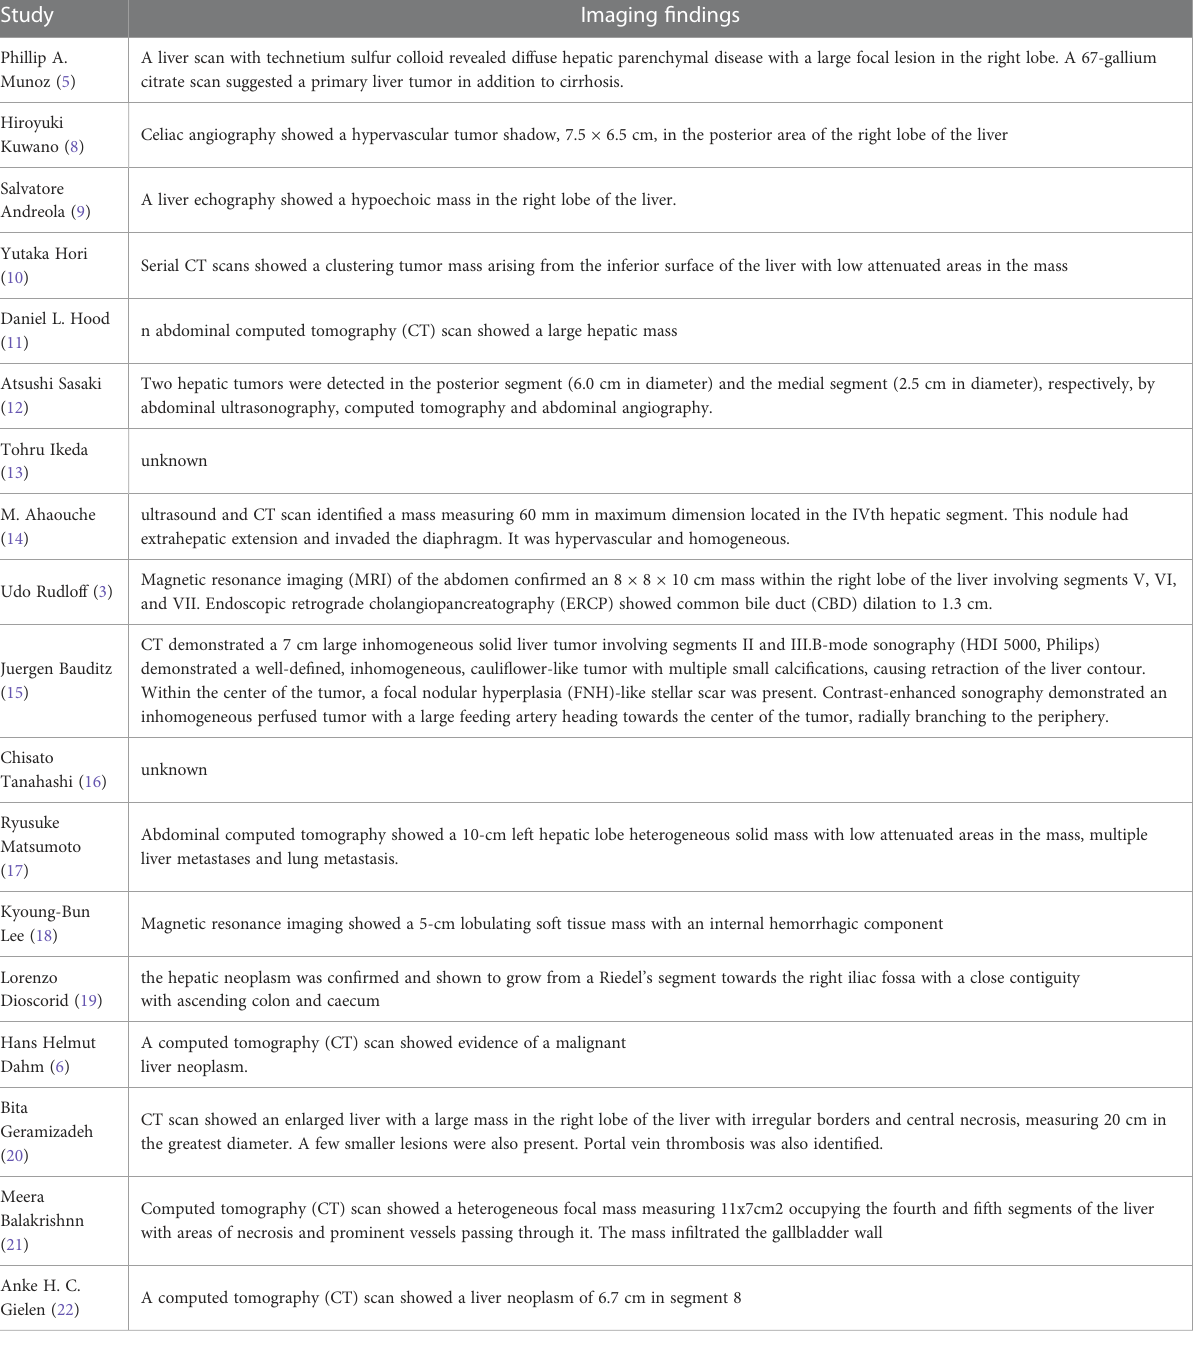
TABLE 3 Imaging fi ndings of hepatic tumors with OCGTs. Study Imaging fi